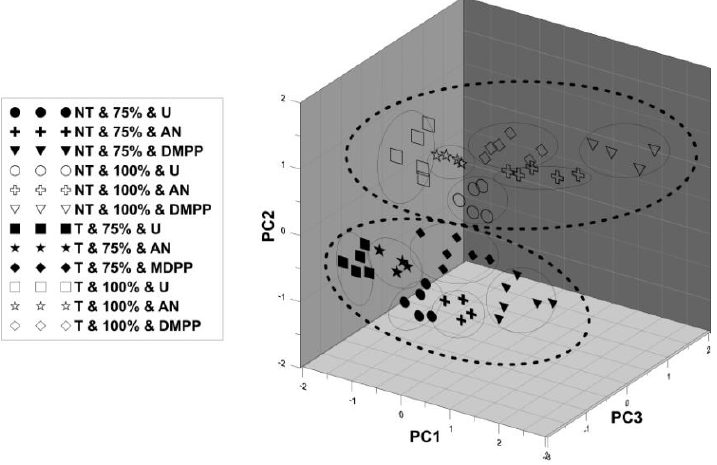
Figure 7. Spatial representation of the main components as a function of the interaction of the three studied variables.